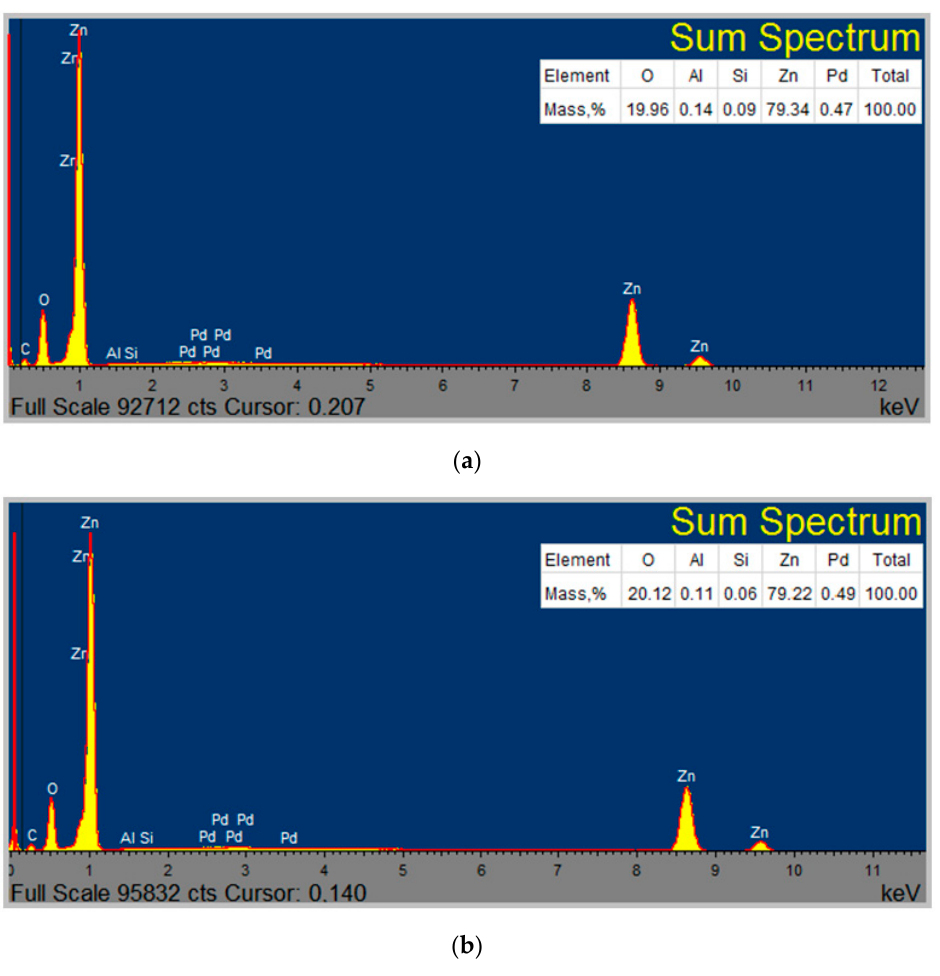
Figure 1. EDX elemental analysis results of the 0.5%Pd/ZnO ( a ) and 0.5%Pd-PVP/ZnO ( b ) catalysts.